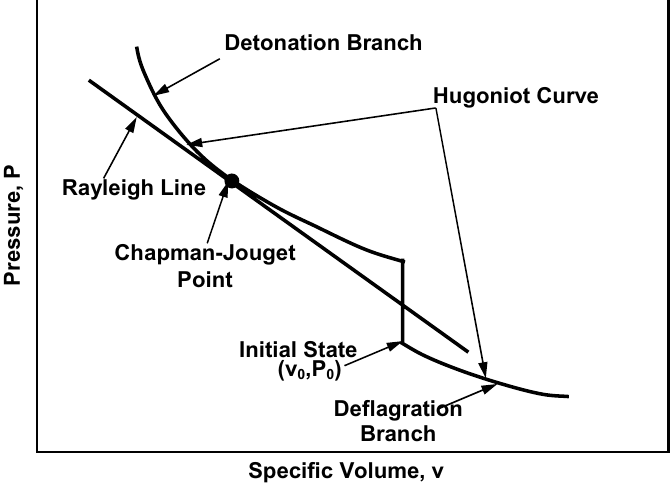
Fig. 1. Pressure vs. specific volume relations in a high-energy explosive material. Please see the text for